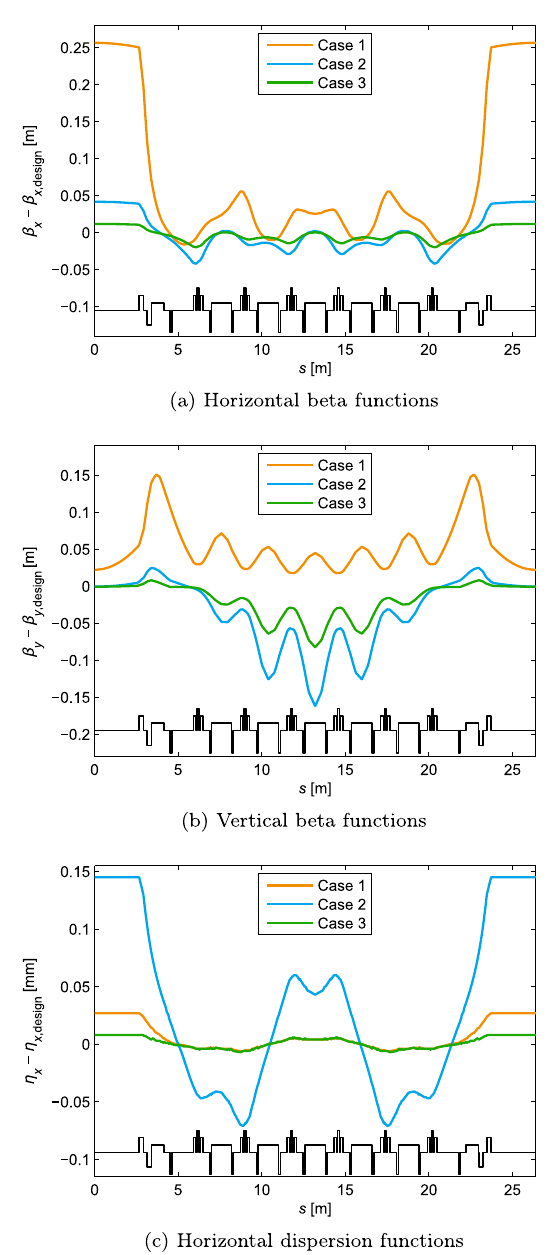
FIG. 3. Difference between the design optics functions and the optics functions from SCVDB lattices. For all cases, the vertical emittance is 6.6 pm rad in the ideal lattice and on average 7.9 pm rad when including